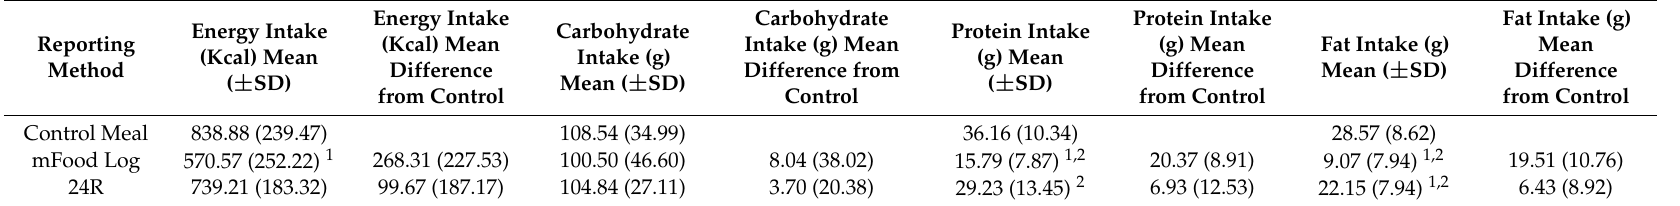
Table 2. Mean energy and macronutrient intake of each method and difference from control meal, n = 14. Reporting